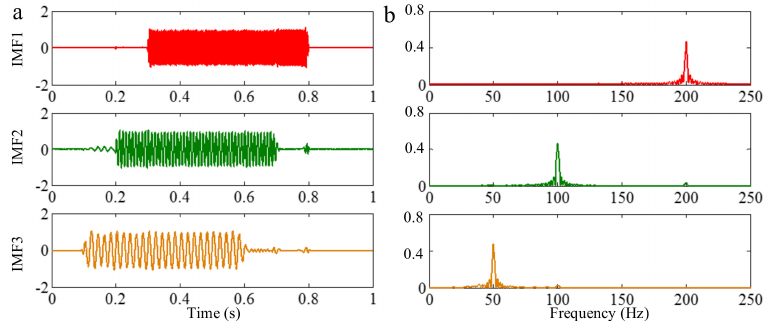
Figure 13. The waveforms of the IMFs 1–3 and the corresponding Fourier spectrums: ( a ) waveforms and ( b ) Fourier